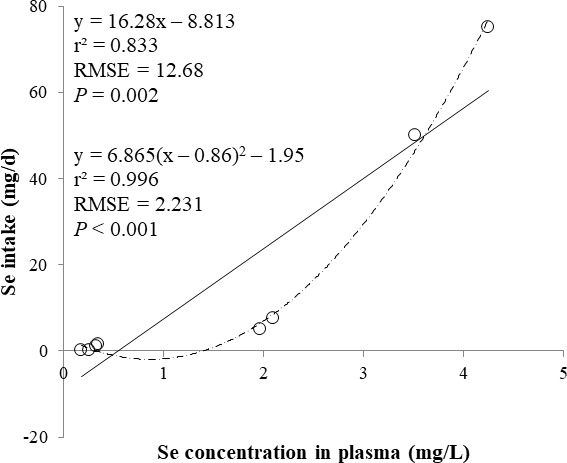
Linear and quadratic regression equations for estimating daily selenium (Se) intake (mg/d) based on the Se concentration in plasma (mg/L) on d 15 and 30.Each data point represents least squares mean of four observations. r2, coefficient of determination; RMSE, root mean square of error.